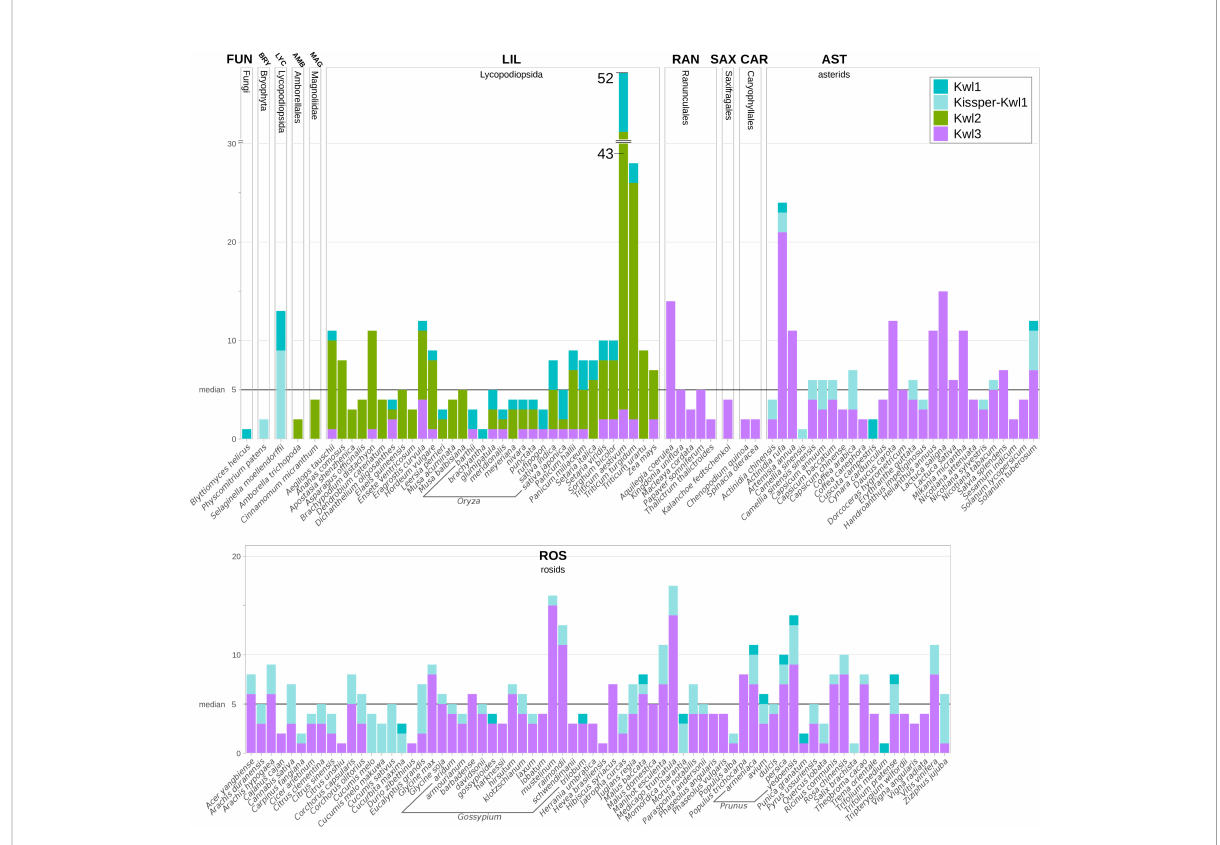
FIGURE 6 Kiwellins detected among speci fi ed species. The black horizontal line indicates the overall median of fi ve Kiwellins per proteome. Colors indicate Kiwellin groups. Dark-turquoise: Kwl1, light-turquoise: Kissper-Kwl1, green: Kwl2, magenta: